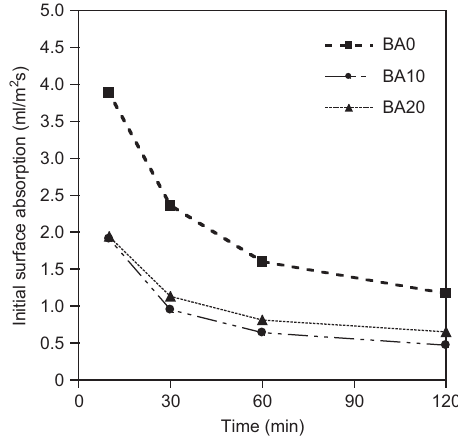
Figure 3 Initial surface absorption vs. testing time.